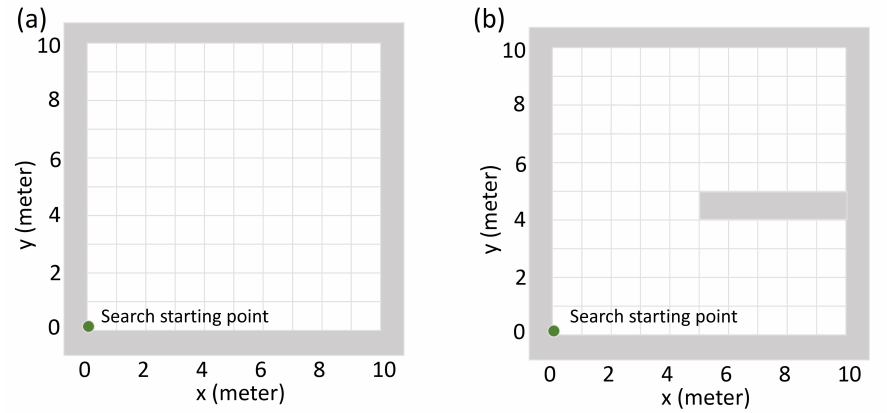
Figure 4. Illustration of the searching areas in the first experiment. ( a ) The searching area that does not have walls inside. ( b ) The searching area that has one wall inside. In both of the searching areas, the detector always starts searching from the lower left